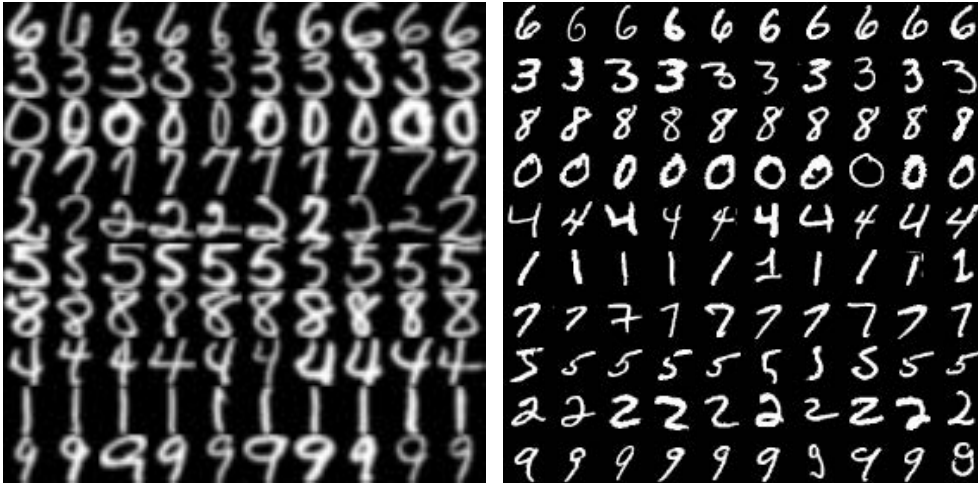
Figure 13. Handwritten digit images from the USPS database ( left ) and MNIST database ( right